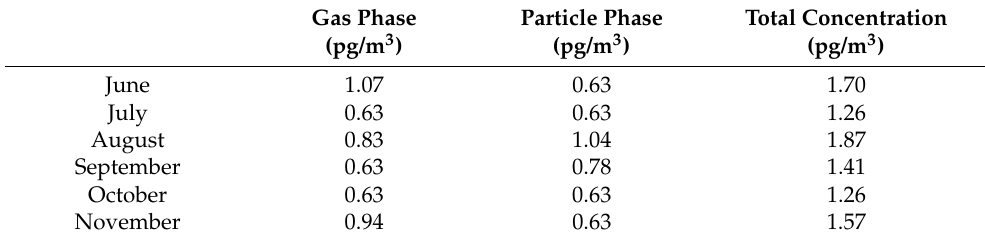
Table 1. Monthly average atmospheric concentrations of PFHxS.